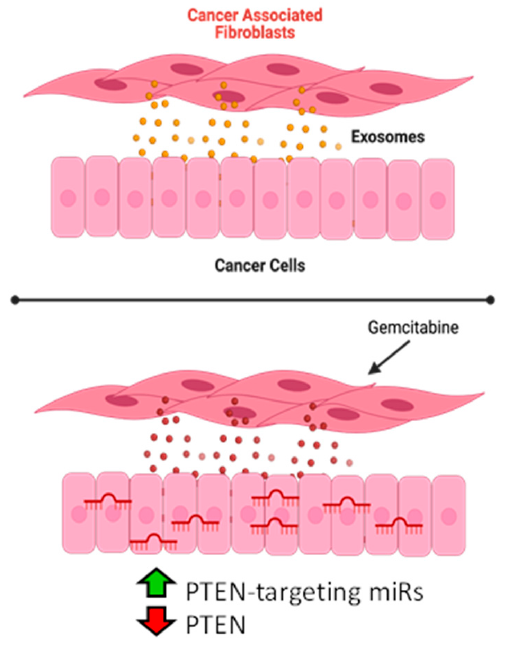
Figure 6. Schematic of proposed mechanism. CAFs routinely release exosomes which are taken up by cancer cells. CAFs treated with gemcitabine release exosomes which have increased expression of PTEN-targeting miRs. Cells that take up these exosomes have increased expression of these miRs and reduced expression of PTEN. Blockade of exosome release restores PTEN ex-pression.